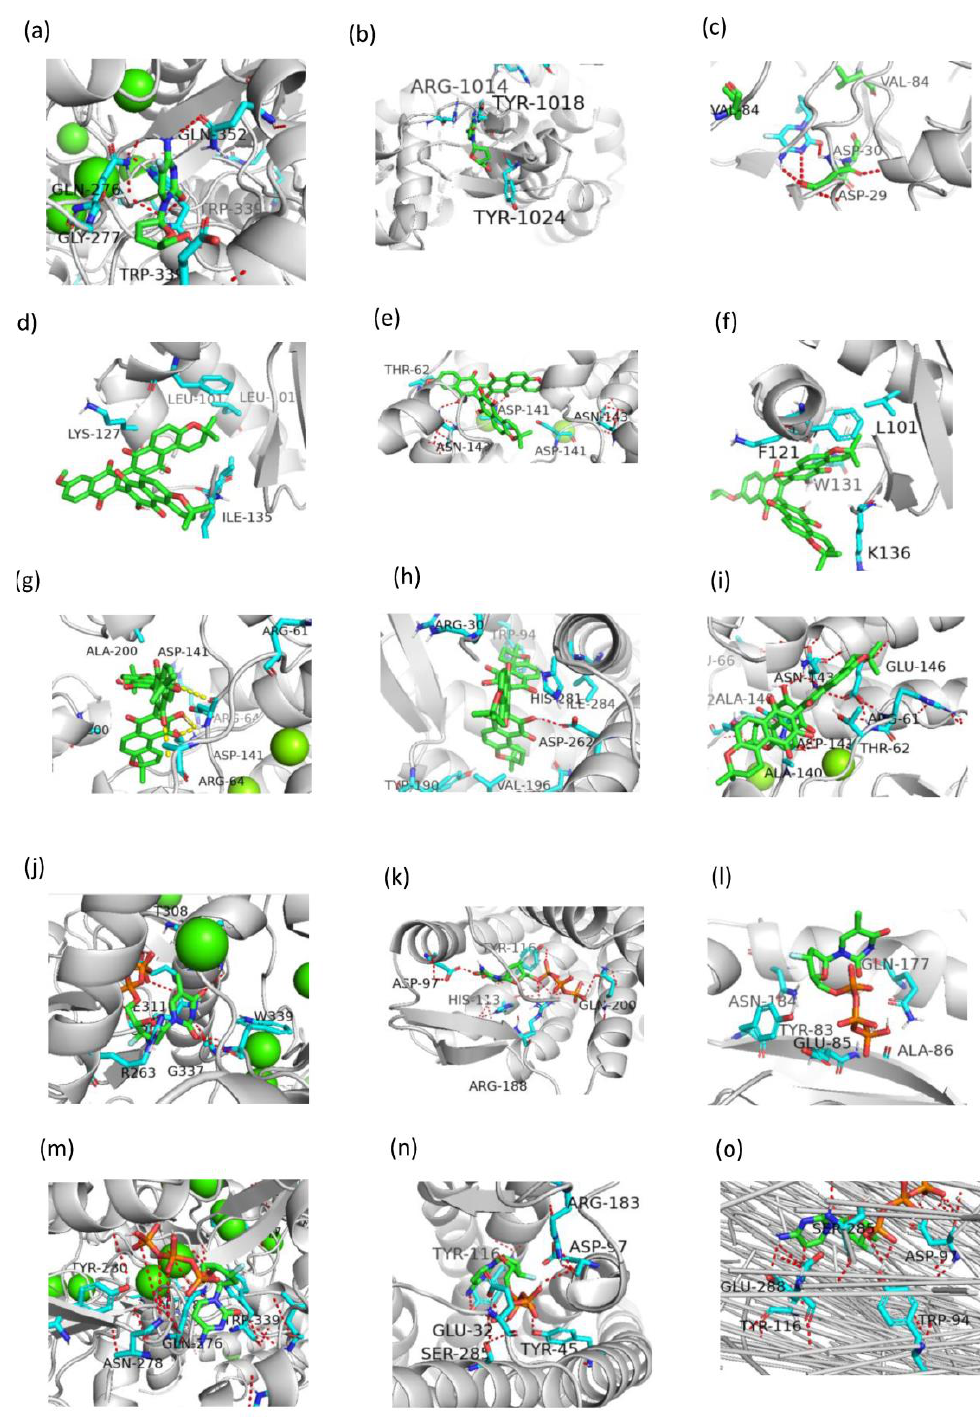
Figure 11. The detailed binding modes corresponding to Figure 10. ( a ): CHEMBL38700-CD299. ( b ): CHEMBL38700-PR. ( c ): CHEMBL1223975-PARB. ( d ): CHEMBL1223977-IN. ( e ): CHEMBL1223977- PARB. ( f ): CHEMBL1223979-CXCR4. ( g ): CHEMBL1223979-PARB. ( h ): CHEMBL1223985-IN. ( i ): CHE MBL2092833-CD299. ( j ): CHEMBL2092833-CXCR4. ( k ): CHEMBL2092833-IN. ( l ):